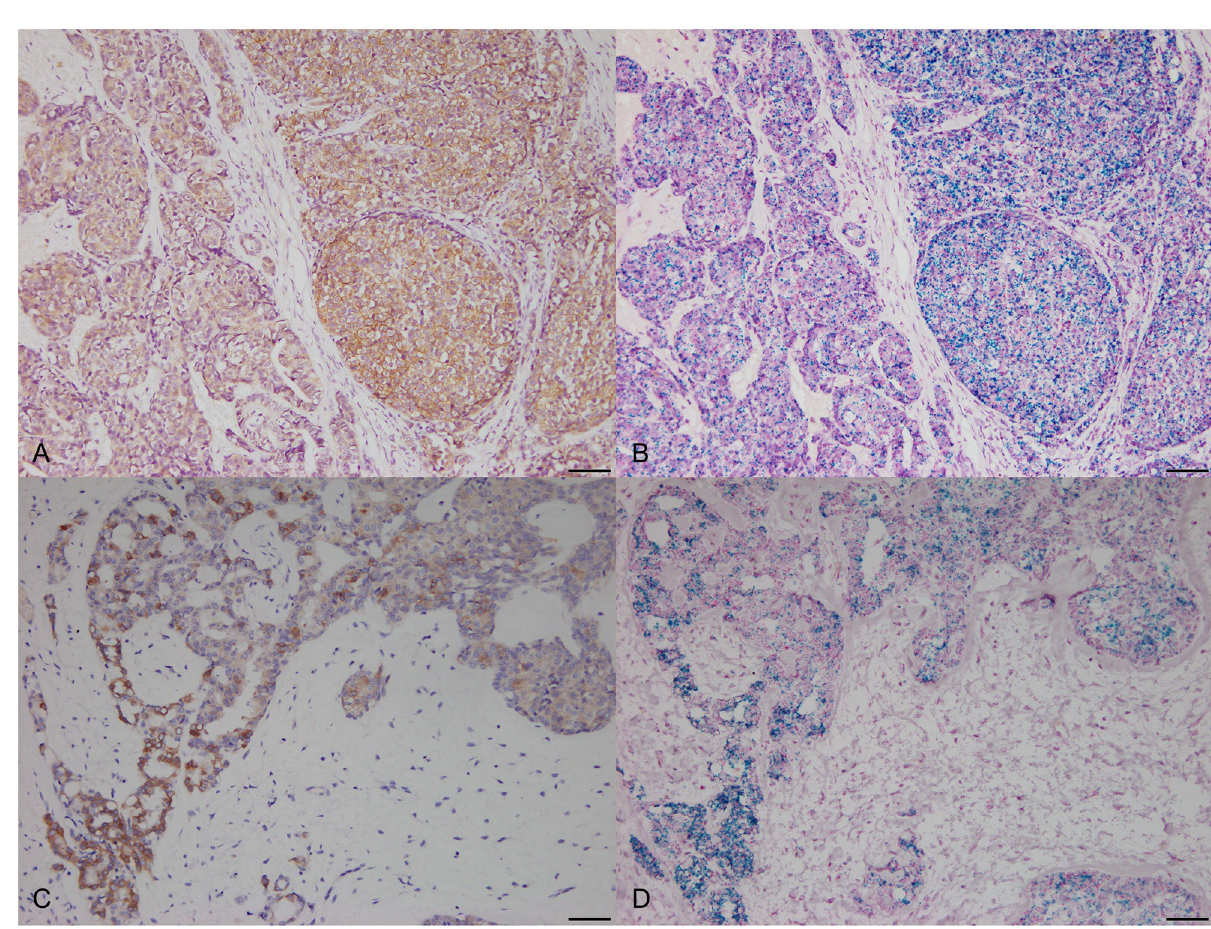
Fig 3. HER2 expression in adjacent serial section of canine mammary gland tissues. (A) Strong membranous staining pattern was observed in the right side of images by IHC 200 × , bar = 50 μ m. (B) Expression of HER2 mRNA dots was observed in corresponding regions of adjacent serial section to Fig 3A by RNA-ISH, 200 × , bar = 50 μ m. (C) Strong membranous staining pattern staining pattern was observed in the bottom-left side of images by IHC 200 × , bar = 50 μ m. (D) Expression of HER2 mRNA dots was observed in corresponding regions adjacent serial sections to Fig 3C by RNA-ISH, 200 × , bar = 50 μ